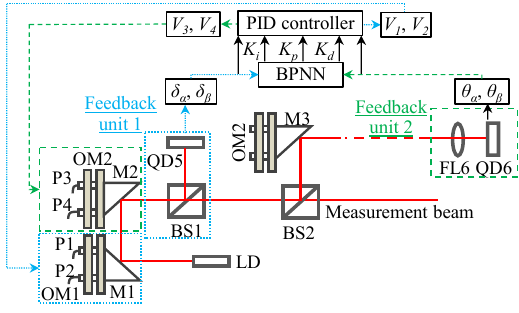
Figure 6. Principle of the IAEC.